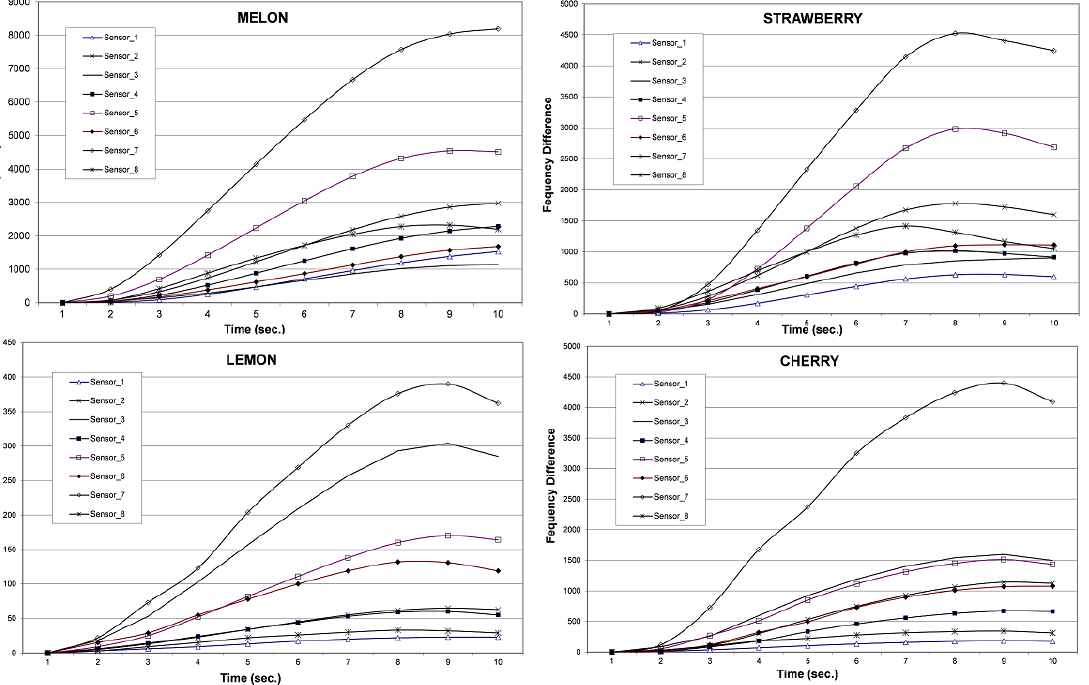
Figure 1. Response of eight sensors to each set of fruit